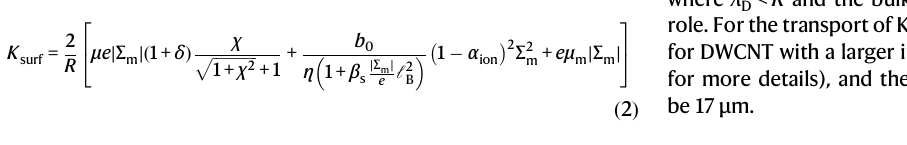
solution concentration for KCl, NaCl, and LiCl. The dashed lines in ( d ) are used to guide the eyes. The curves in ( f ) are theoretical predictions. Error bars are derived from the standard deviation of experimentally measured voltage drop currents. Source data of this fi gure are provided as a Source Data fi